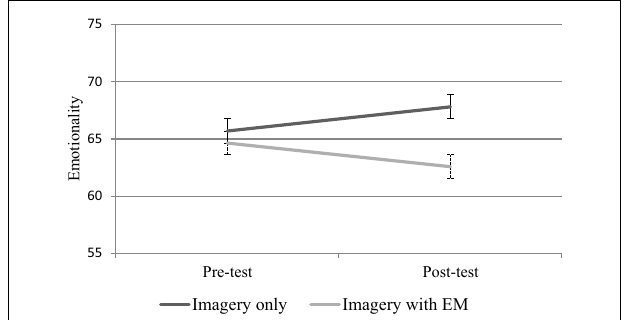
FIGURE 1 | Mean emotionality ratings with standard error bars for imagery only ( n === 17) and imagery with eye movements (EM; n === 17) conditions